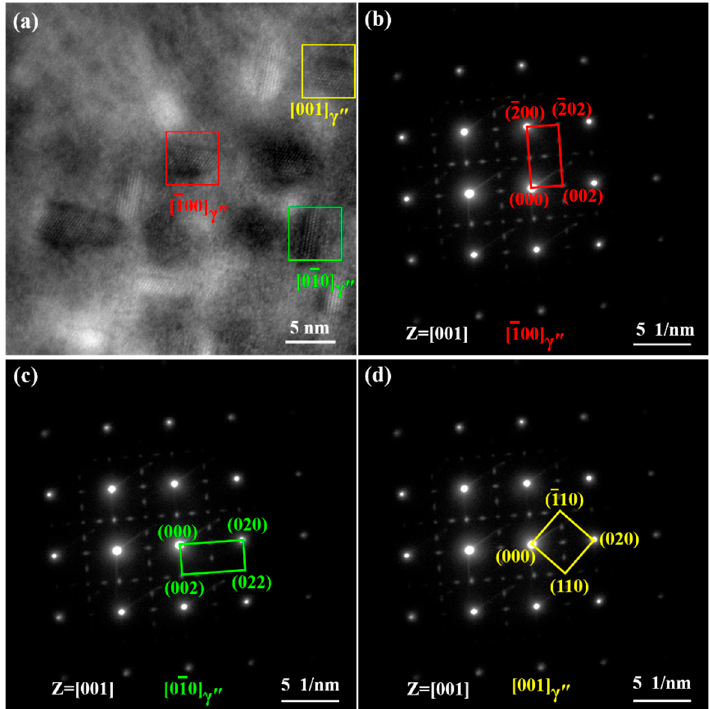
Figure 6. High-resolution TEM (HRTEM) image and selected area diffraction (SAD) patterns of γ″ phases in specimen A. ( a ) HRTEM image; ( b ) SAD pattern of γ′′ [100] ; ( c ) SAD pattern of γ ′′ [010] ; ( d ) SAD pattern of γ′′ [001] .